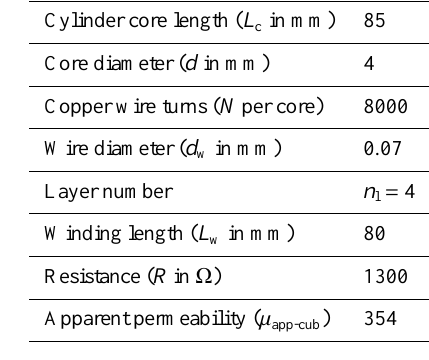
Table 1. Design parameters of the cubic induction sensor pro- totype for a NEMI goal: 0.7pT / √ 4nV / (Hz) and i PA = 20fA /